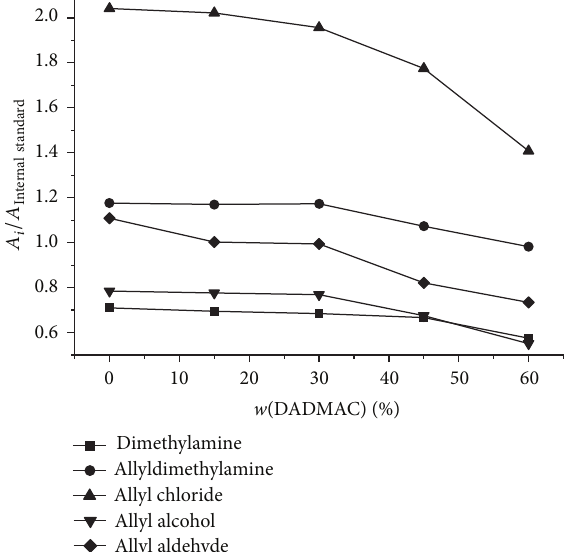
Figure 6: Effect of solvents on extraction